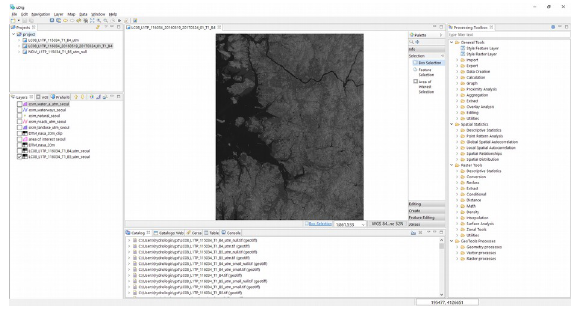
Figure 6. The workspace of the tutorial in uDig: the Processing Toolbox View and the dataset loaded in the Map View.